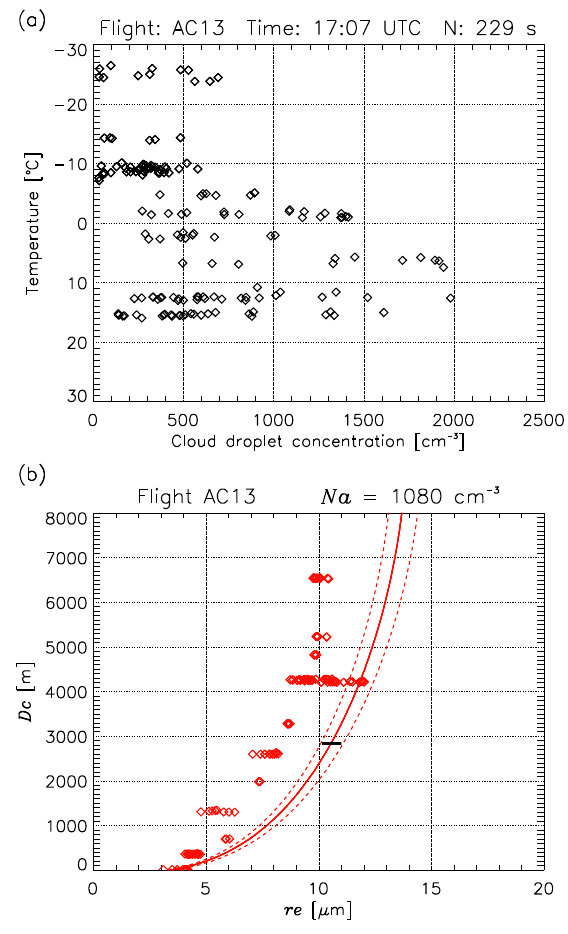
Figure 13. (a) Cloud droplet concentration measured with the CCP–CDP probe as a function of temperature for flight AC13. Each dot indicates a 1Hz average concentration. The sample number and the approximate time of the cloud profile are shown at the top of the panel; (b) similar to Fig. 7 for Flight